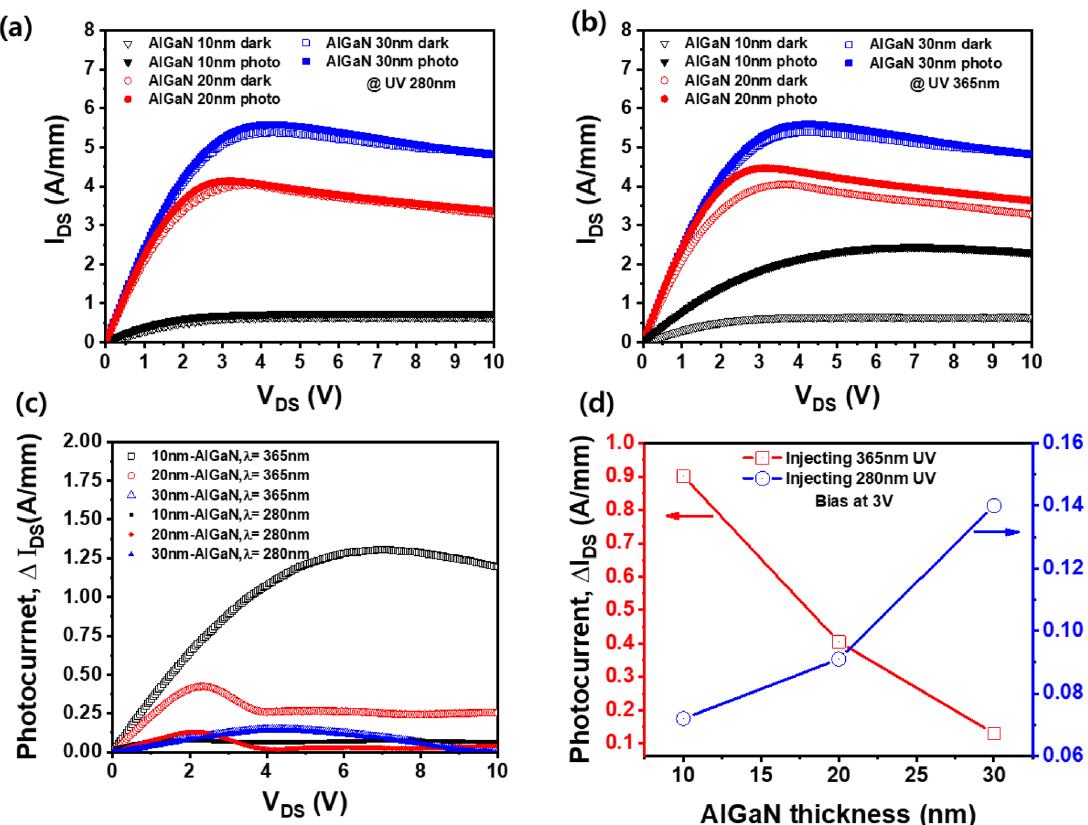
Figure 2. I–V characteristics of AlGaN/GaN HEMTs with different AlGaN barrier thicknesses under dark and UV illuminations using 280 nm ( a ) and 365 nm ( b ) wavelengths as exposure light sources. ( c ) Photocurrent (ΔI DS ) versus source–drain voltages of HEMTs with different AlGaN barrier thicknesses using 280 nm and 365 nm UV light. ( d ) Photocurrent between source and drain as a function of AlGaN barrier thickness at 3.0 V drain